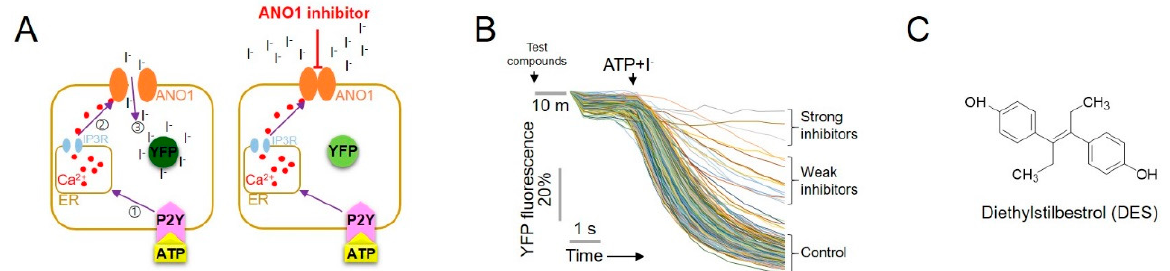
Figure 1. High-throughput YFP reduction assay used to screen for ANO1 inhibitors. ( A ) Cell-based high-throughput YFP reduction assay. ATP-induced P2Y receptor increased calcium levels, which in turn activated ANO1, causing an influx of iodide and a decrease in YFP. ( B ) YFP fluorescence monitored using 96-well plates showing the inhibitory effect of strong inhibitors. ( C ) Chemical structure of the ANO1 inhibitor, diethylstilbestrol (DES).